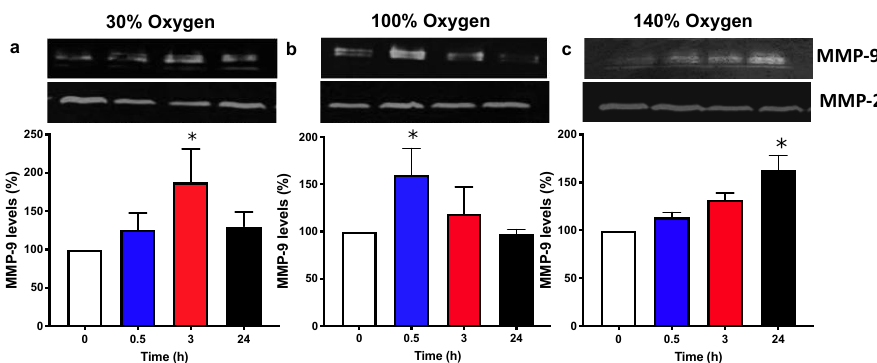
Figure 5. Zymographic analysis of matrix metallo-proteinase (MMPs) in human plasma from different groups of healthy subjects after one hour of oxygen exposure in ( a ) mild (30% O 2 ), ( b ) high (100% O 2 ) and ( c ) very high hyperoxia (140% O 2 ). The pictures show a representative zymograph gel for all the subjects submitted to the analysis. The histograms display the percentage (mean ± SEM) in comparison to baseline (Time 0), which was set at 10. * p < 0.05 vs. base line before oxygen exposure (Time 0), for one-way ANOVA followed by Dunnett’s post hoc test.